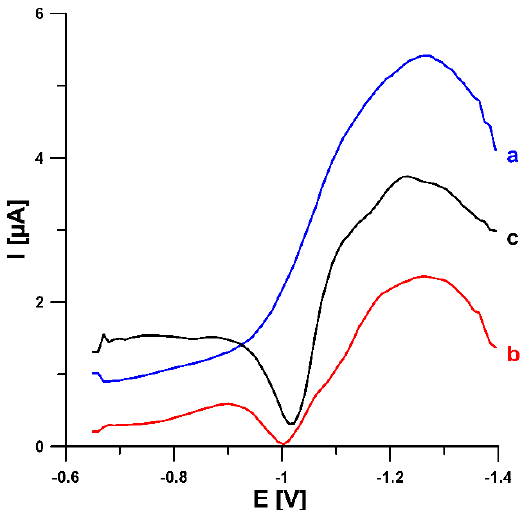
Figure 6. SWAdSVs of 10.0 nM U(VI) obtained at the N ‐ CMK ‐ 3/GCE (a), PbF/GCE (b) and Pb ‐ N ‐ CMK ‐ 3/GCE (c) in 0.2 M acetate buffer of pH 4.0 containing 0.025 μ M Pb(NO 3 ) 2 (b and c) and 0.06 mM cupferron. The SWAdSV parameters: E dep of − 1.1 V, t dep of 60 s, E acc of − 0.65 V, t acc of 180 s, f of 200 Hz and E SW of 25 mV.